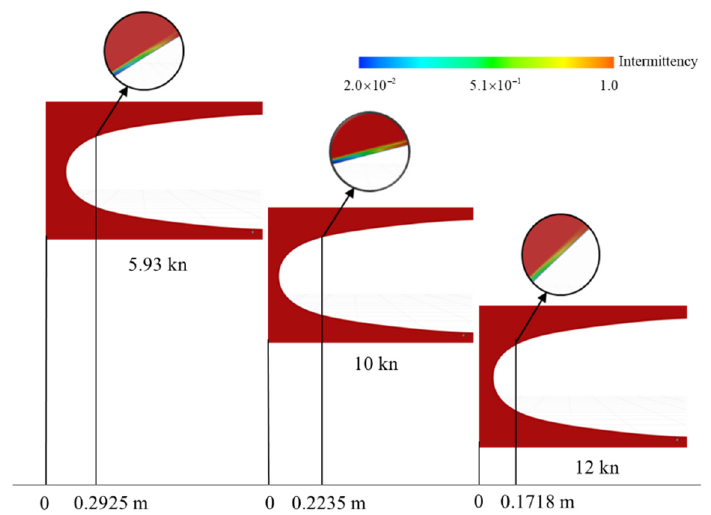
Figure 9. The transition position at the velocity of 5.93 kn.